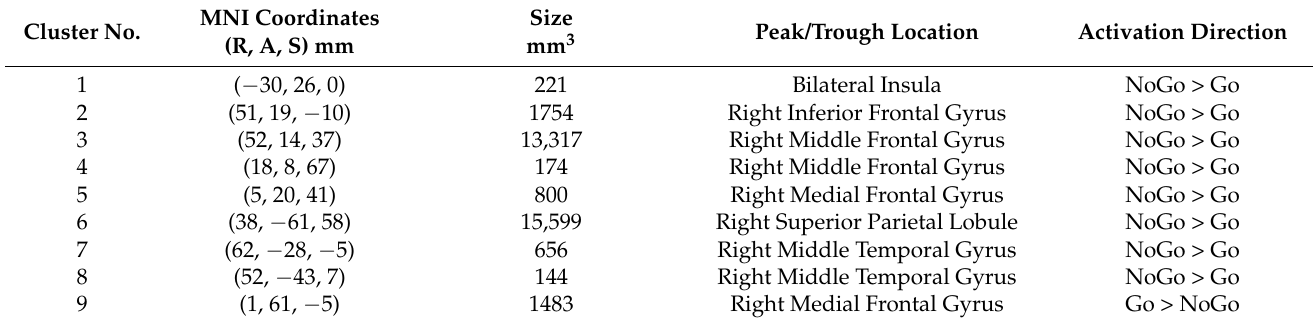
Table 2. Significant clusters identified during successful NoGo BOLD responses and their MNI coordinates, sizes in mm 3 , locations at the peak/trough, and activation